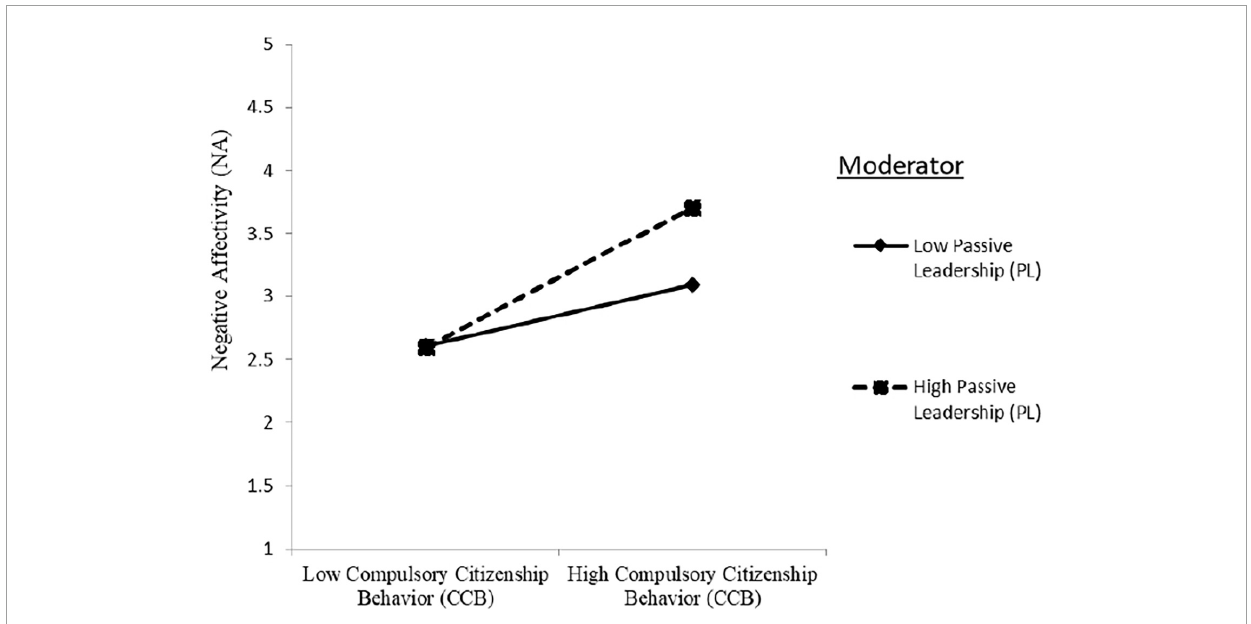
FIGURE2 Moderation effect of passive leadership on the relationship between compulsory citizenship behavior and innovative affectivity.